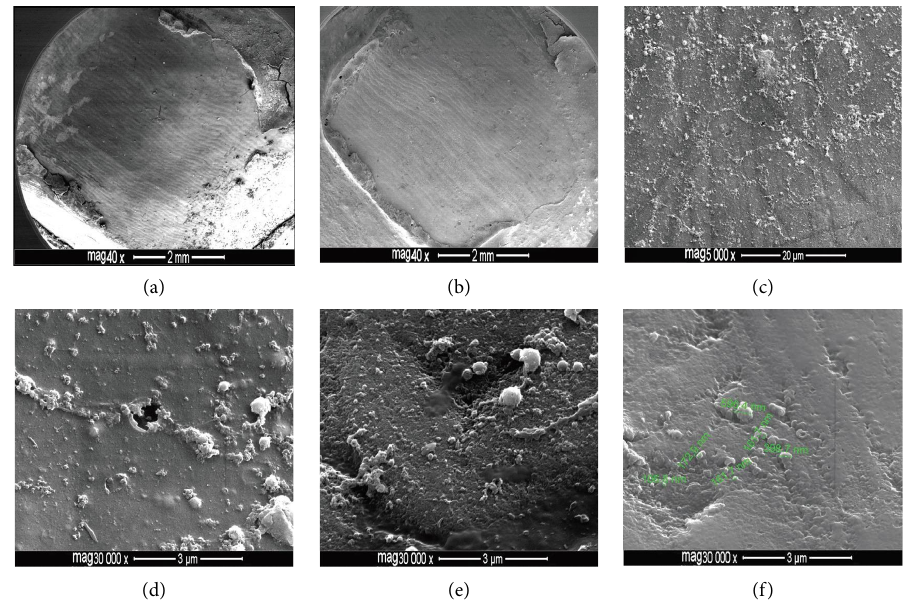
Figure 2: FE-SEM images of premolar buccal enamel surfaces etched with 7% nHA-SEP and debonded at 24h. Te conditioned teeth elicited regular, unblemished enamel surfaces with no or minimal residual adhesive (a, b) and abundant nCaP precipitations (c–f) abolishing and surrounding the micropores (d,